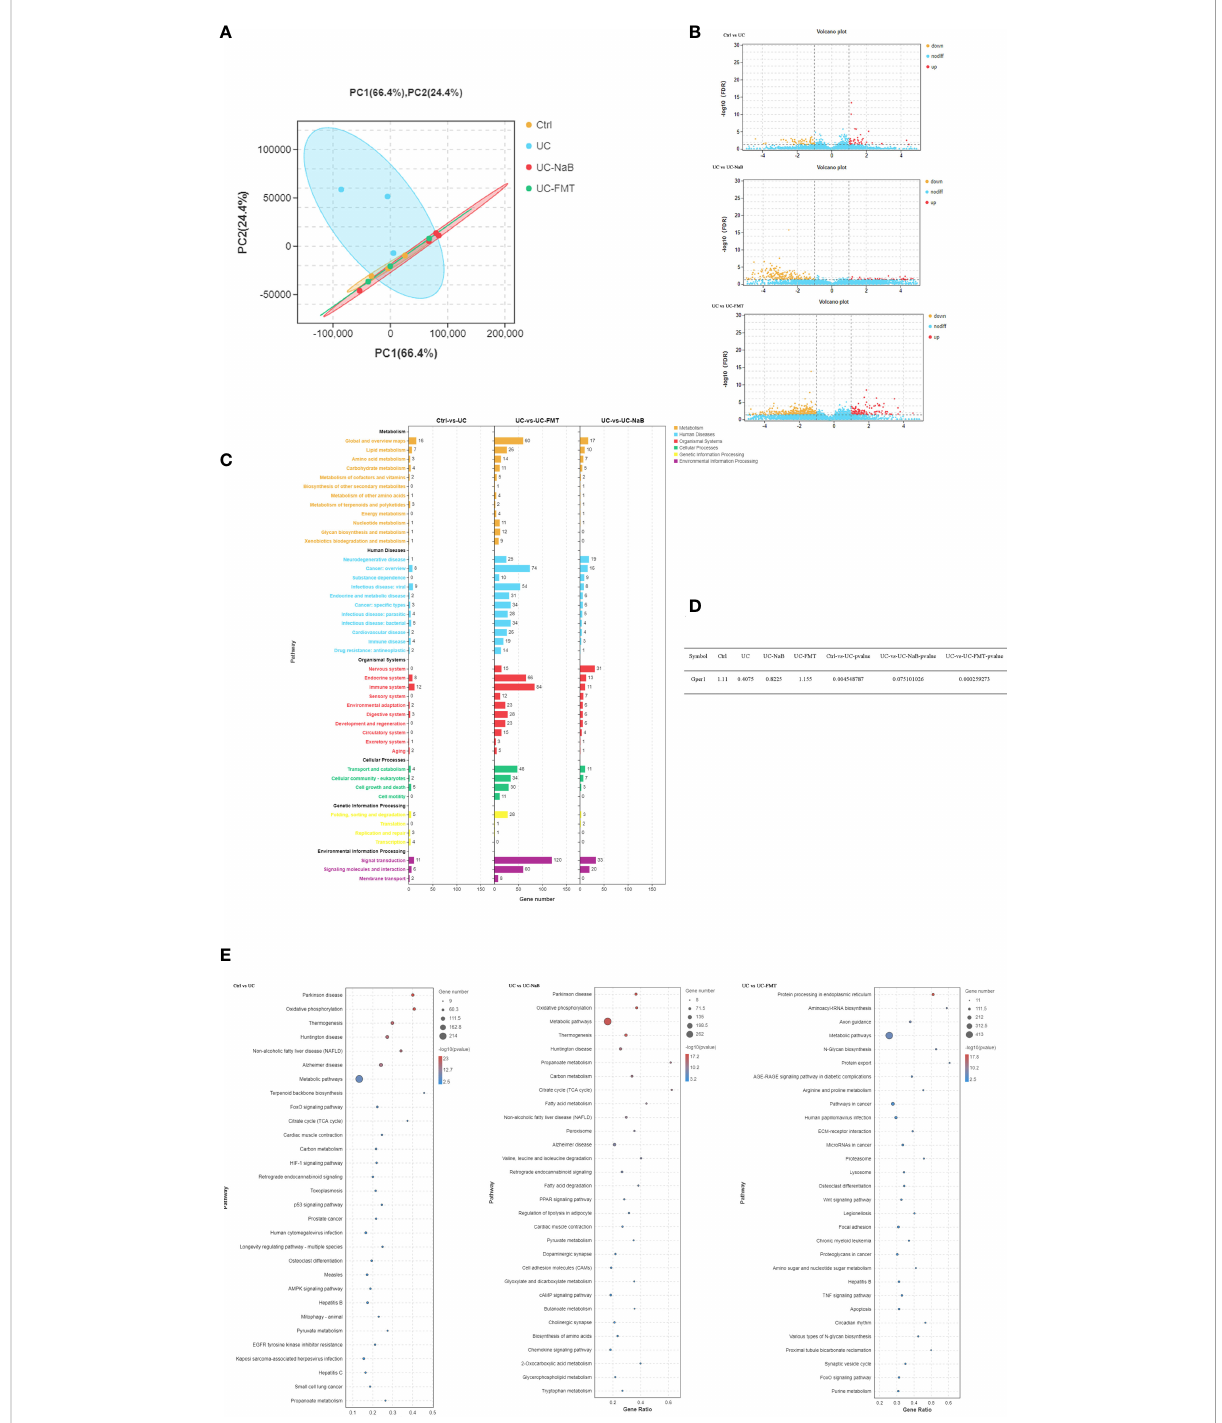
FIGURE 3 PCA was performed with the R package gmodels (http://www.rproject.org/) in this experiment for each of the sample groups, including their biological replicates. (A) . The expression pro fi les of the identi fi ed DEGs (B) . Yellow and red points represent signi fi cant DEGs with an FDR<0.05 and |log2FC|>1, and blue points indicate non-signi fi cance DEGs. (C) . The vertical axis represents the number of DEGs per pathway in KEGG annotation. The X-axis shows the gene numbers for each different term. (D) . The GPER expression levels in each group were compared. (E) . Enriched GO terms identi fi ed during the analysis of